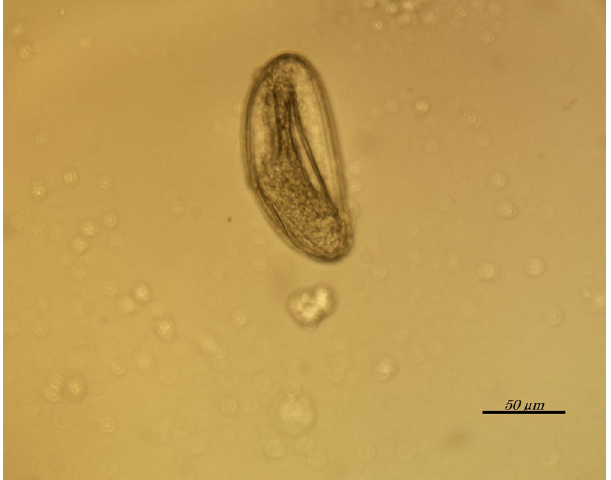
Fig. 5. The appearance and accumulation of air bubbles under the shell of Passalurus ambiguus eggs at the zygote and crushing stages and the formation of blastomeres with the use of